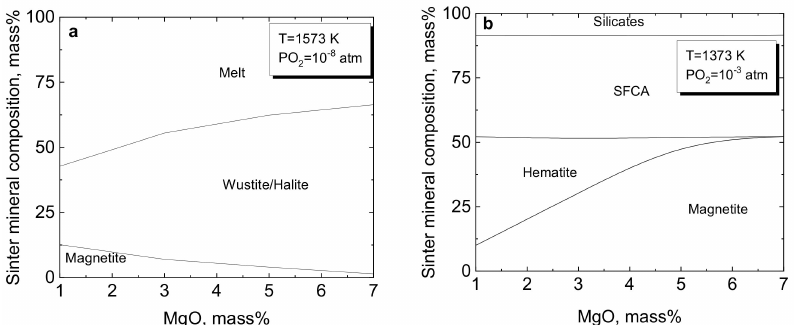
Figure 13. Mineral composition of sinter under varied MgO at temperature of ( a ) 1573 K and ( b ) 1373 K.